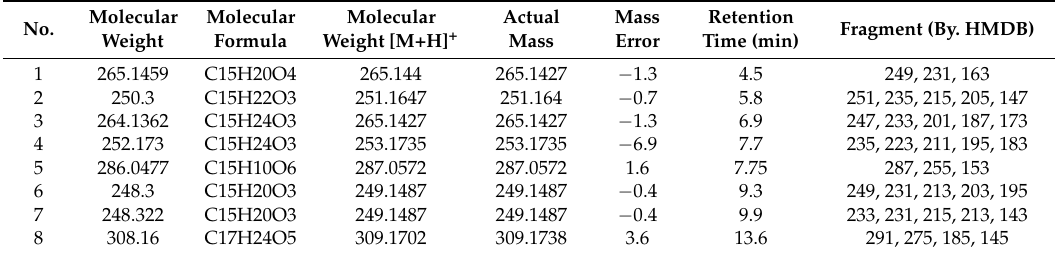
Figure 5. Liquid chromatography–mass spectrometry (LC–MS/MS) analysis of IJE ( A ) chromatogram of IJE, (1) Heliespirone A, (2) 3-Ketoapotrichothecene, (3) O-Formyloreadone, (4) 1-Hydroxyepiacorone, (5) Luteolin, (6) 1 β -Hydroxyalantolactone, (7) Heliannuol B, (8) Dihydrocumambrin. ( B ) LC–MS/MS analysis of luteolin and 1 β -hydroxyalantolactone (1 β -HA) within IJE. Fragmentation pattern spectrum of 1 β -HA and luteolin. Table 3. Identification of chemical ingredients of IJE using LC–MS/MS.